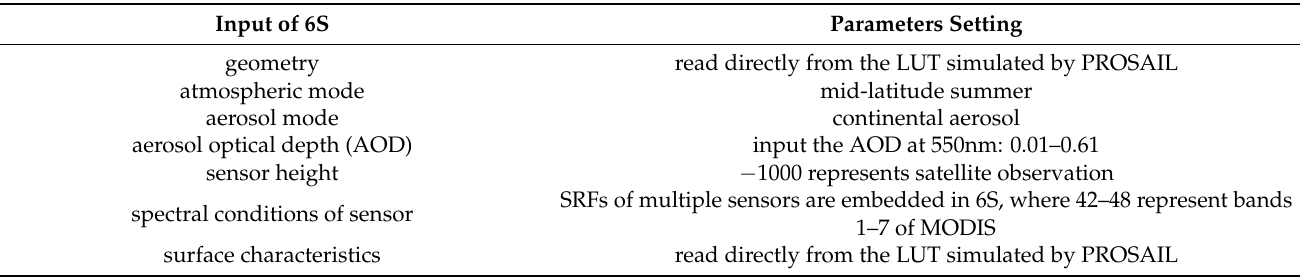
Table 3. Input parameters of the